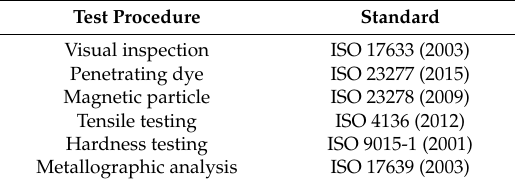
Table 3. Test procedures and standards.